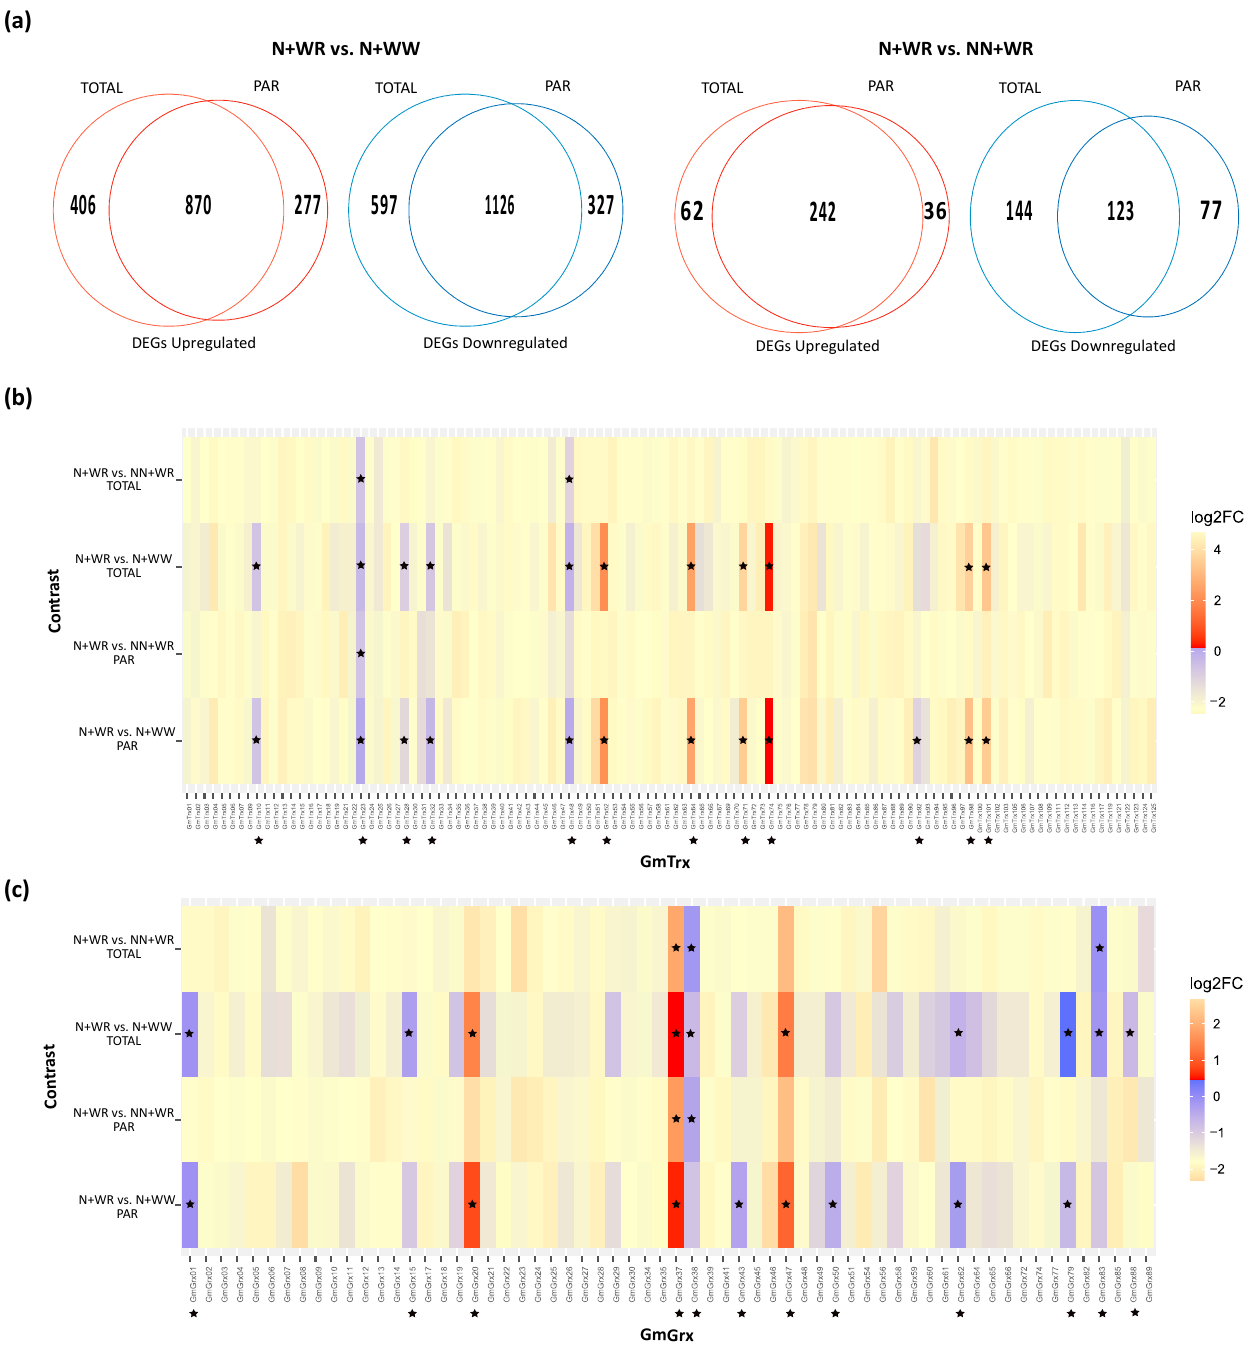
Figure 4. Differentially expressed gene (DEG) analysis and GmTrx and GmGrx expression profiles in nodulated (N) and water-restricted (WR) plants with respect to well-watered (WW) and non- nodulated (NN) plants. ( a ) Venn diagrams showing up- and down-regulated genes in the N+WR vs. N+WW and N+WR vs. NN+WR contrasts in total RNA (TOTAL) and polysome-associated mRNA (PAR) fractions. ( b ) Expression profiles of GmTrx . ( c ) Expression profiles of GmGrx . Heatmaps were constructed from the RNA-seq experimental data. Asterisks indicate the differentially expressed GmTrx and GmGrx genes found in our study. Genes with |log2FC| > 1 and adjusted p -value (padj) < 0.05 were considered differentially expressed.